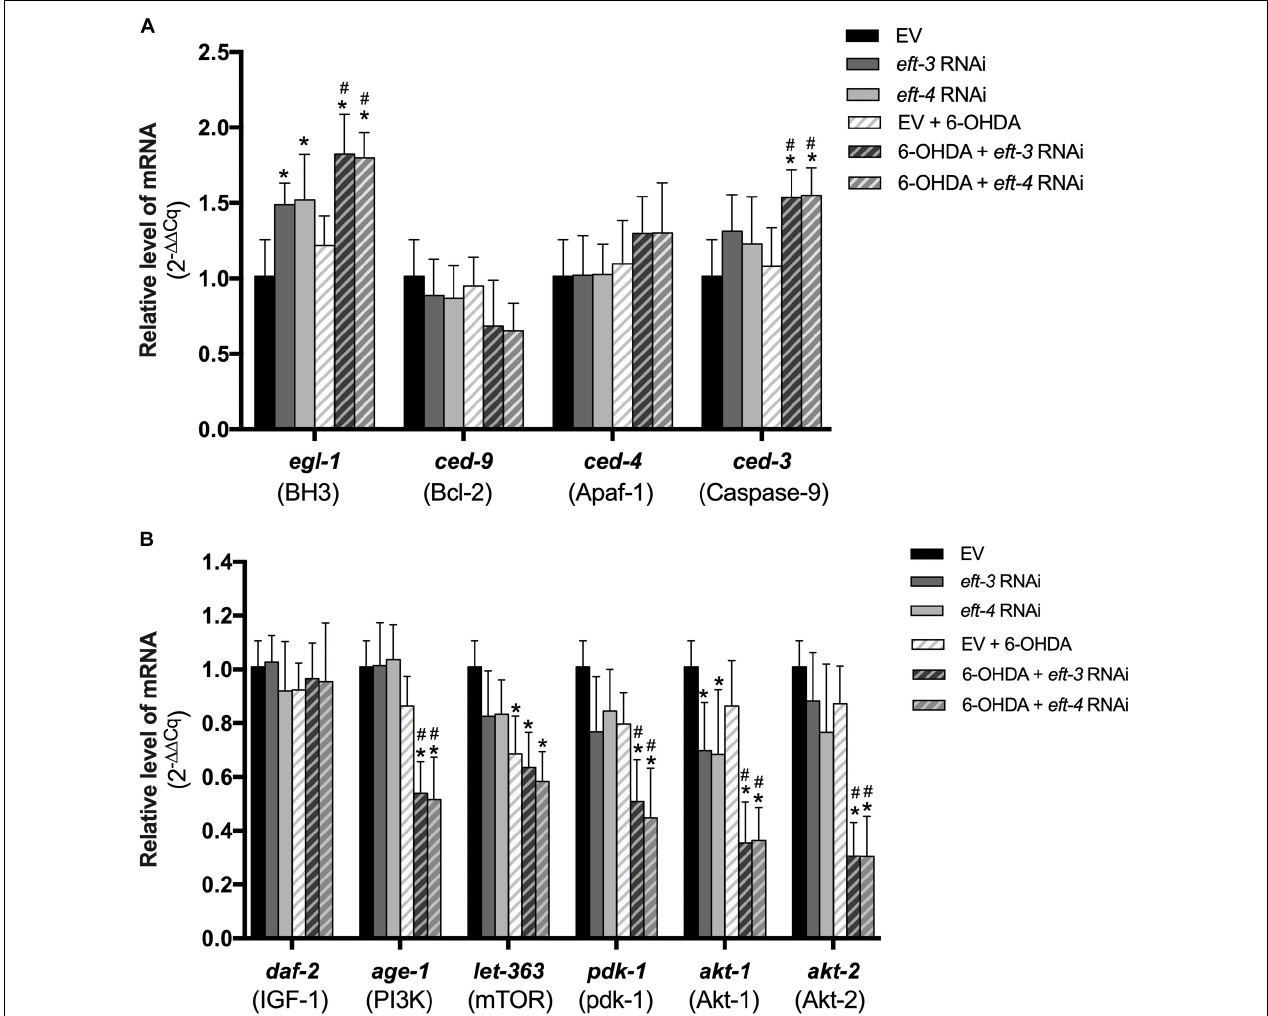
FIGURE 5 | Effects of eft-3 / eft-4 RNA interference (RNAi) and/or 6-hydroxydopamine (6-OHDA) exposure on apoptosis and survival modulation. (A) Fold change of mRNA expression levels of apoptosis signaling genes including egl-1 , ced-3 , ced-4 , and ced-9 in empty vector (EV) RNAi-treated, eft-3 / eft-4 RNAi-treated, 6-OHDA-treated, and co-treatment of eft-3/eft-4 RNAi and 6-OHDA-treated groups. (B) Fold change of mRNA expression levels of survival signaling genes including daf-2 , age-1 , let-363 , pdk-1 , akt-1 , and akt-2 in EV RNAi-treated, eft-3 / eft-4 RNAi-treated, 6-OHDA-treated, and co-treatment of eft-3/eft-4 RNAi and 6-OHDA-treated groups. All data represent the mean ± SEM of three independent biological replicates. The asterisk (*) indicates a significant difference between the EV RNAi-treated and eft-3/eft-4 RNAi and/or 6-OHDA-treated worms ( p < 0.05). The hash (#) indicates a significant difference between only 6-OHDA-treated and combined 6-OHDA with eft-3 or eft-4 RNAi-treated worms ( p <